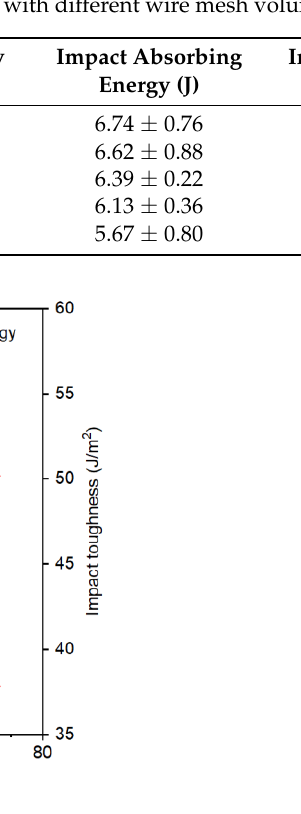
Figure 3. Variation trend of the impact properties of PWMCPPs with different wire mesh volume fractions.